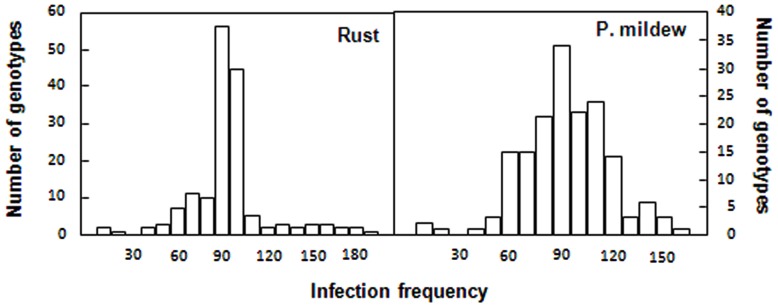
Distribution of the infection frequency of the rust and powdery mildew infection in the oat collection. Infection frequency recorded as number of pustules per unit area for rust and percentage of leaf covered by mycelium for powdery mildew were converted into relative values, expressed as percentage of the reading of the susceptible controls, respectively.